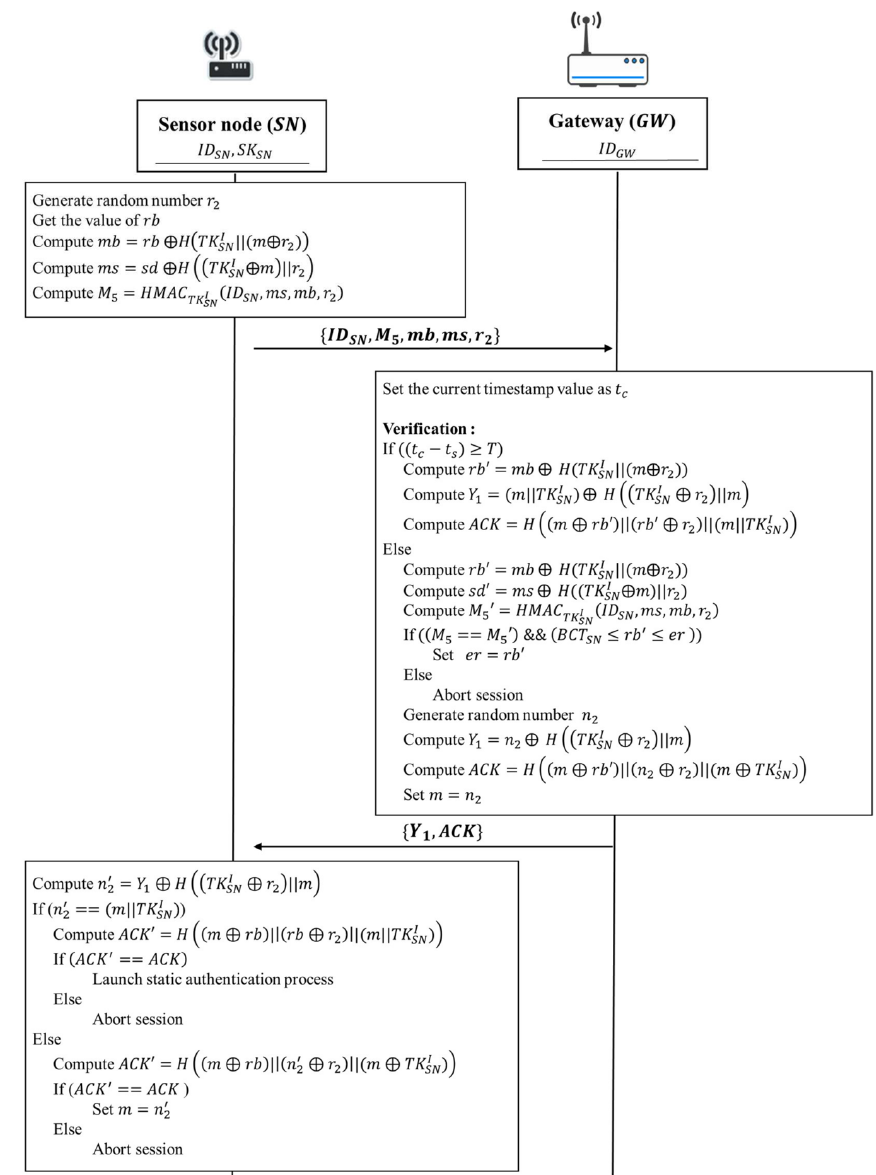
Figure 6. The continuous authentication phase of the proposed